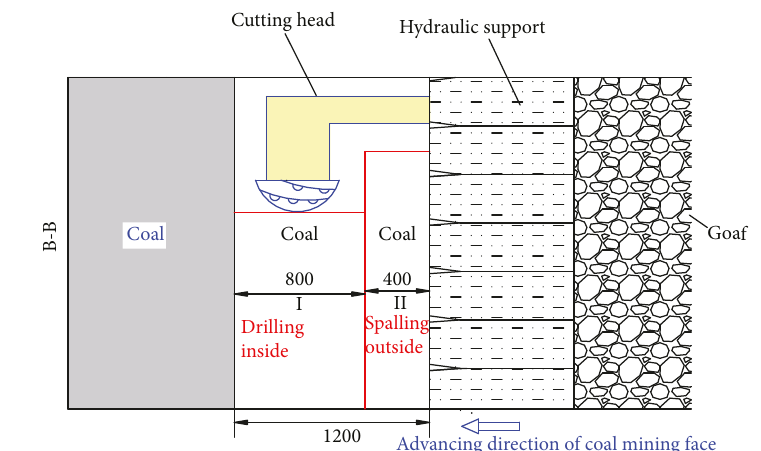
Figure 6: Working mechanism (top